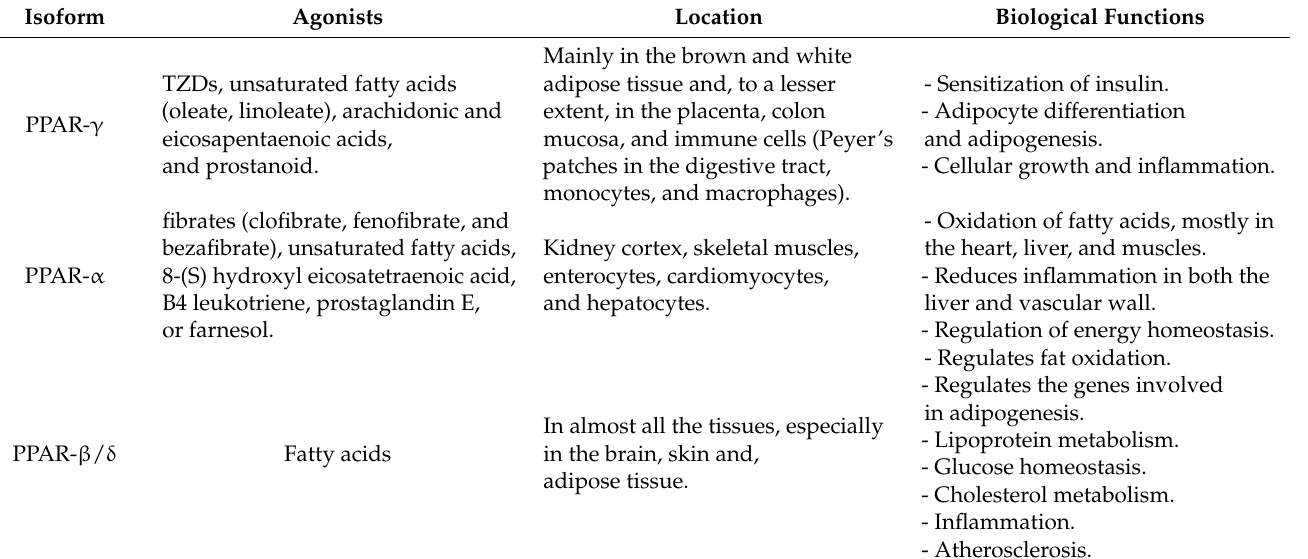
Figure 3. Principal functional domains of PPARs. Table 1. Biological functions of PPARs.